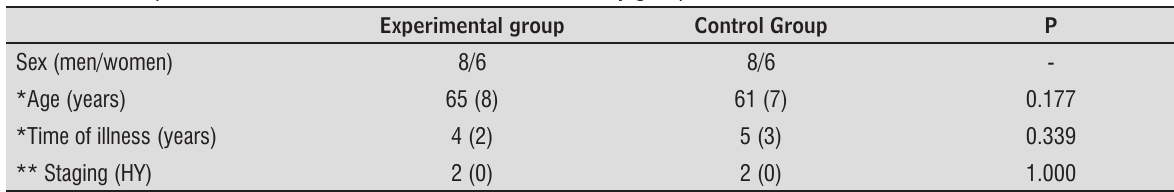
Table 2 - Comparison of baseline characteristics between study groups Experimental group Control Group P